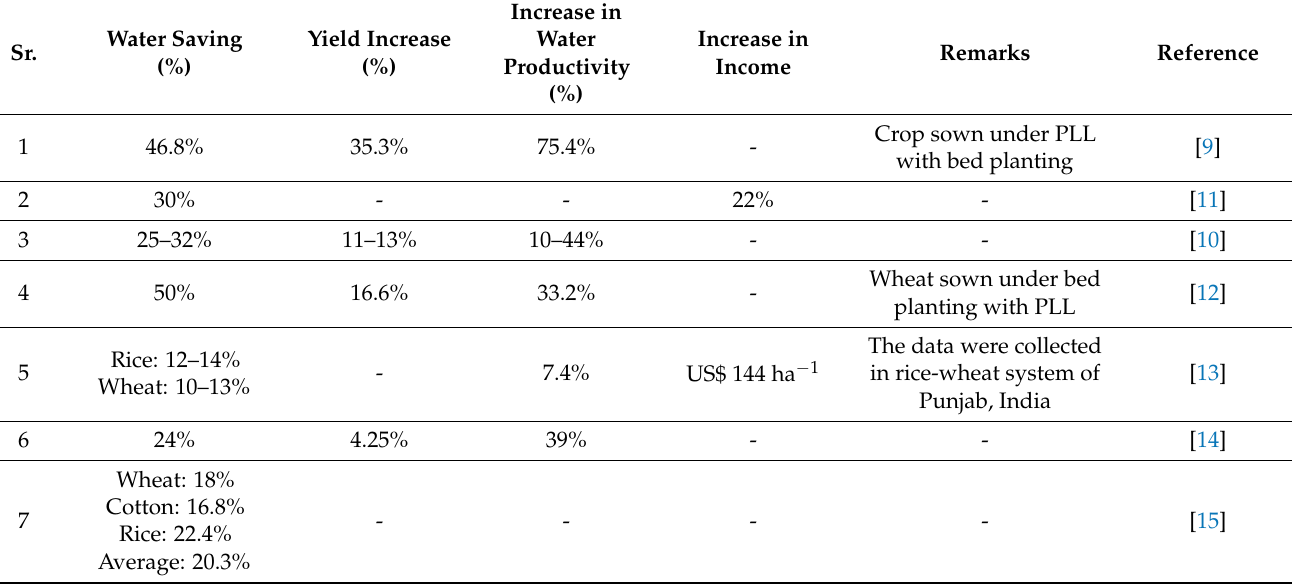
Table 1. Water saving, yield increase, and water productivity improvement under